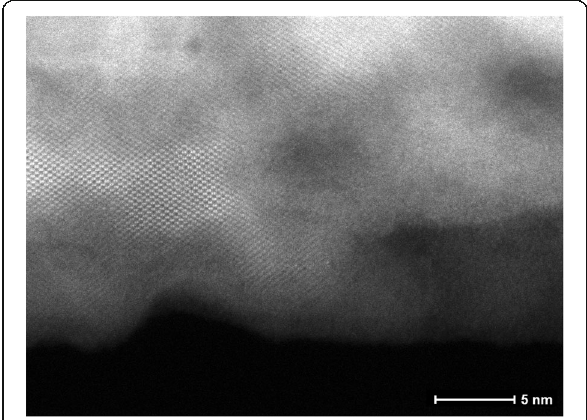
Fig. 1 TEM image of a silicon nanowire fabricated by means of metal-assisted chemical etching with HF:H2O2:EtOH=30:1:20 etching solution. The original resistivity of silicon was 8 – 12 m Ω cm. The sample presents a high surface roughness; however, no quantitative considerations on the porosity content can be done, due to the intrinsic limitation of TEM analysis, since the transmission signal is relative to the whole volume of the wire. On the other hand,